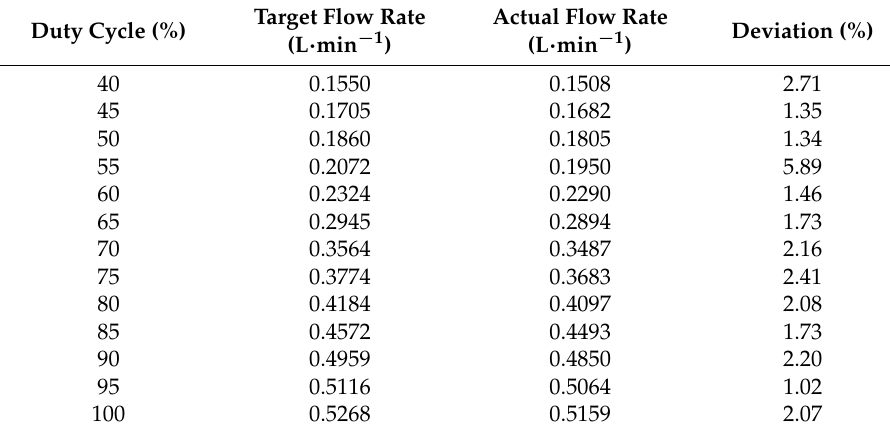
Table 2. System flow